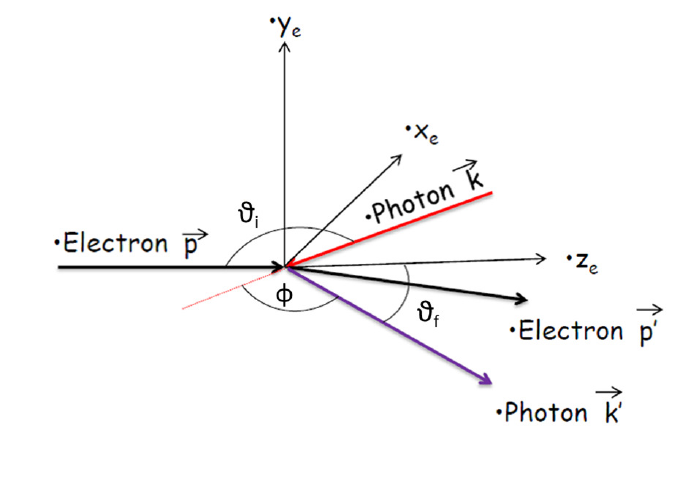
Figure 2. Kinematic and geometric variables of Compton Backscattering: input ( (cid:126) p ) and output ( (cid:126) p (cid:48) ) electron momenta, (cid:126) k , (cid:126) k (cid:48) wave vectors of incident and scattered photon, respectively; orientation and amplitude of the incident θ i , scattered θ f photon angles and φ = θ i − θ f relative